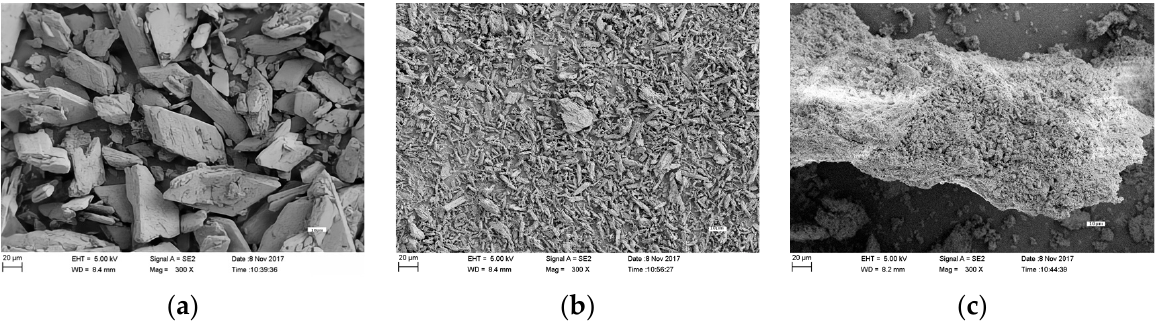
Figure 6. ( a ) Phosphate tailing powder in static culture without PSF7. ( b ) Phosphate tailing powder in table culture without PSF7. ( c ) Phosphate tailing powder after adding